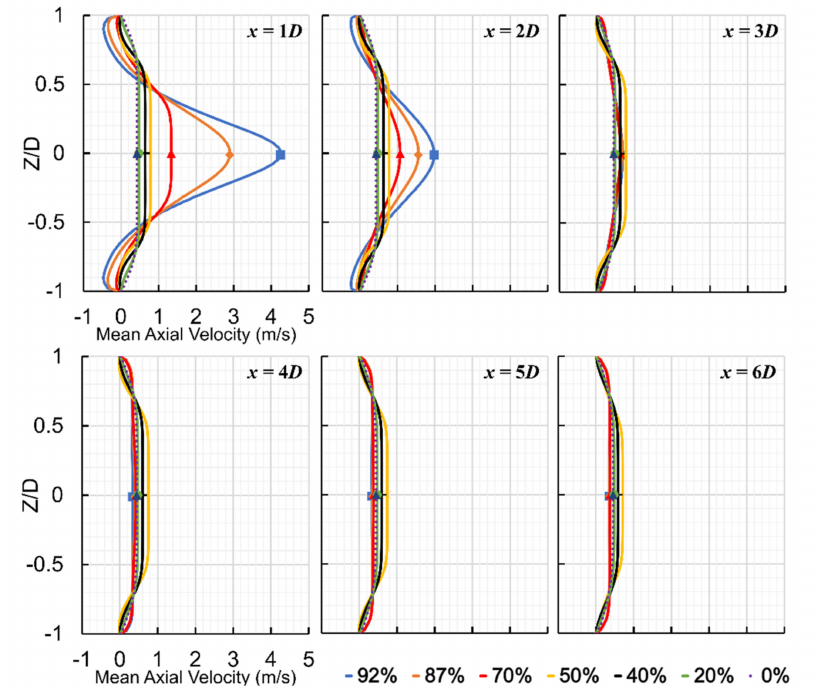
Figure 5. Mean axial velocity at six different locations (1D to 6D) downstream of stenosis for all severity